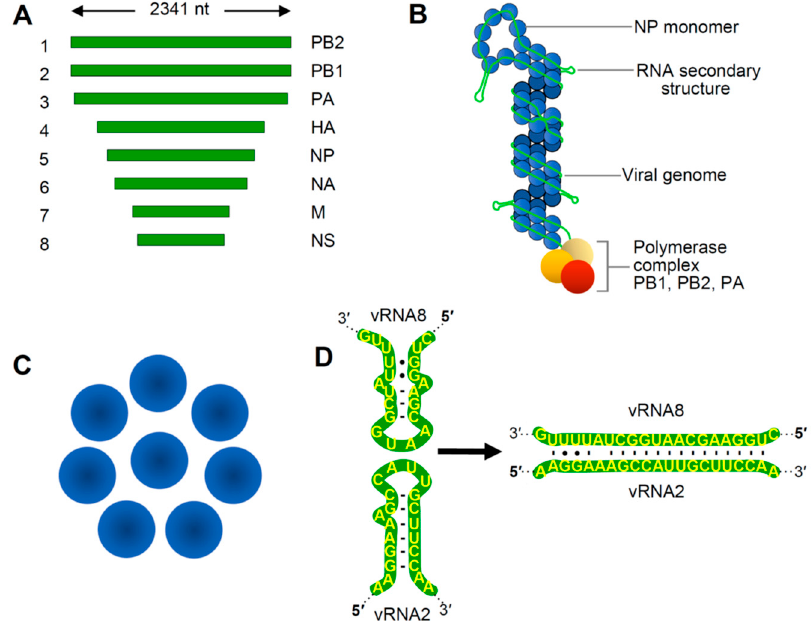
Figure 1. Genome-related structures for Influenza A virus. ( A ) Linear representation of influenza A virus (IAV) genome segments, labeled 1 to 8 (left), along with corresponding proteins encoded by each (right). ( B ) Schematic representation of a generic IAV vRNP complex with relevant structural features labelled. Not to scale. ( C ) Axial view of 7 + 1 arrangement of vRNPs depicting their parallel alignment inside IAV particles. ( D ) Predicted RNA secondary structures of interacting RNA regions in vRNP 8 and vRNP 2 (left) and their in trans RNA–RNA interaction (right) that mediates vRNP association [9]. The local RNA secondary structures (left) are predicted to extend from their respective vRNPs (as shown in B, labeled, RNA secondary structure), thereby facilitating nucleation the interaction.